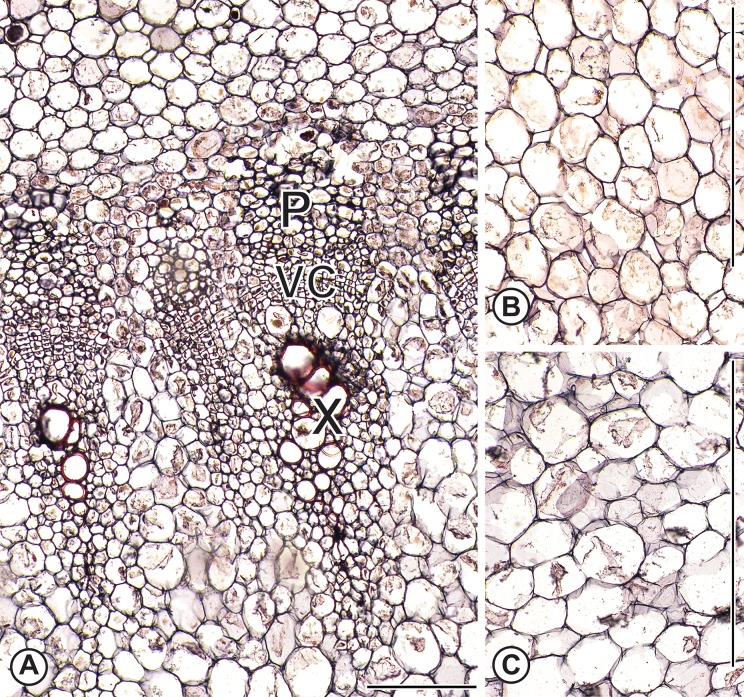
Anatomy of flowering kale and pak choi.(A) Flowering kale vascular cambium and associated secondary xylem and phloem in flowering kale stem corresponding to the region with the small circle in Fig 3B. No intrusive growth is visible and cells are nearly isodiametric in contrast to the sheared cells near the turnip vascular cambium (Fig 5D). (B) and (C) Parenchyma cells in the vicinity of the small rectangles of Fig 3B and 3H of flowering kale and pak choi, respectively. Scale: A: 100μm; B, C: 400μm. X = xylem; P = phloem; VC = vascular cambium.